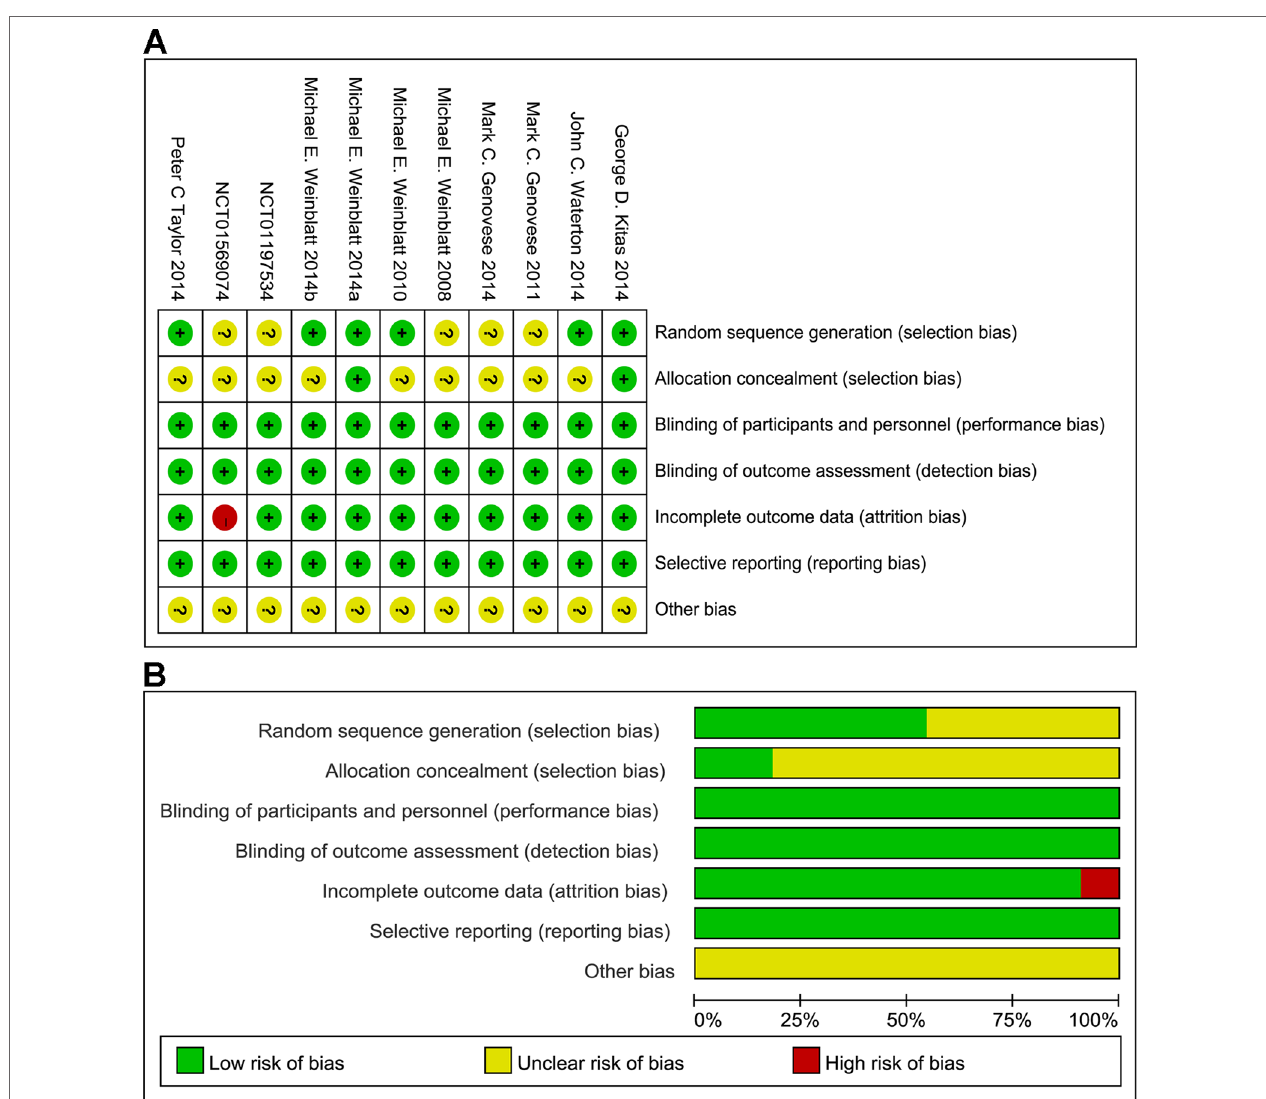
FIGURE 2 | Summary (A) and graph (B) of the risk of bias in the included trials by Cochrane risk of bias tool. Assessments were based on the reviewers’ judgment of each